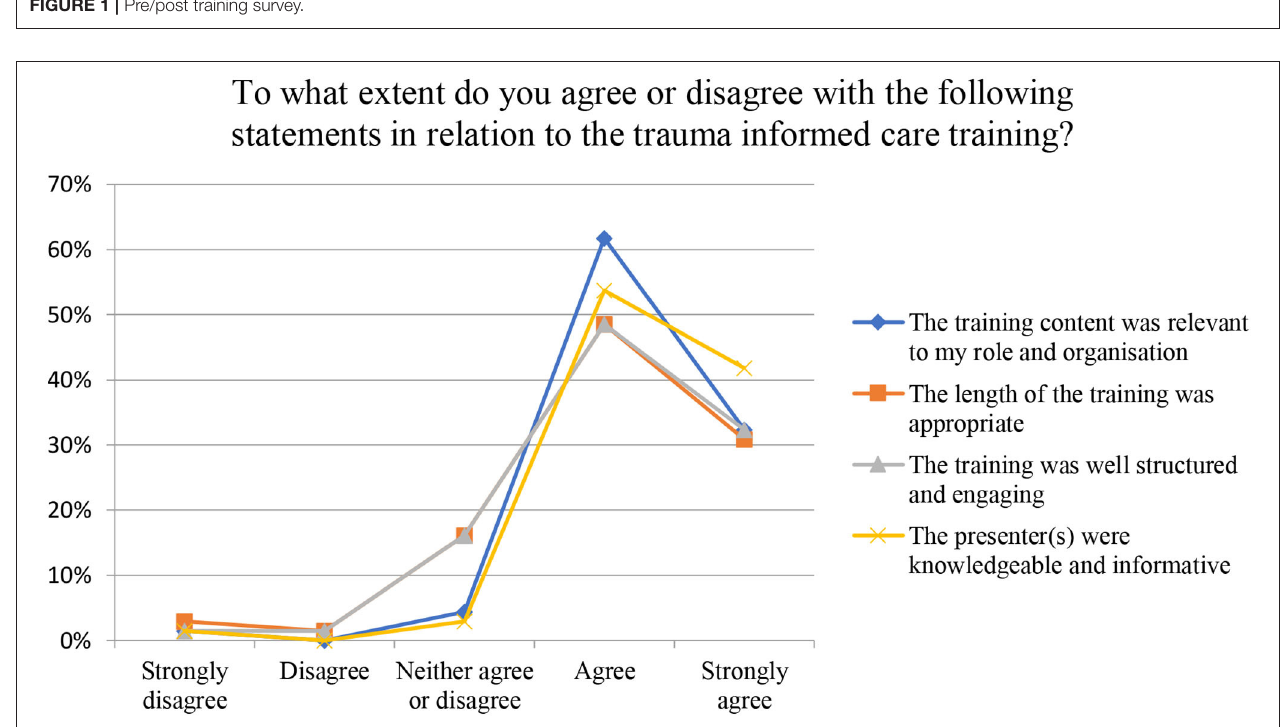
FIGURE 2 | Post training trauma informed care (TIC)